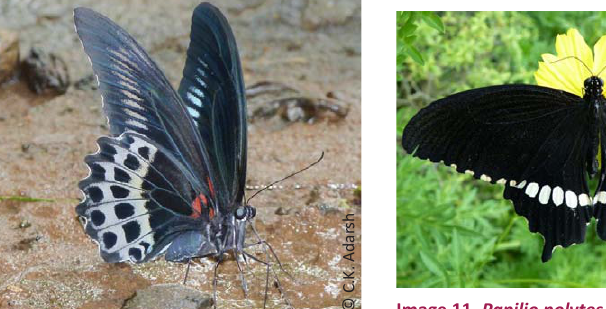
Image 10. Papilio polymnestor